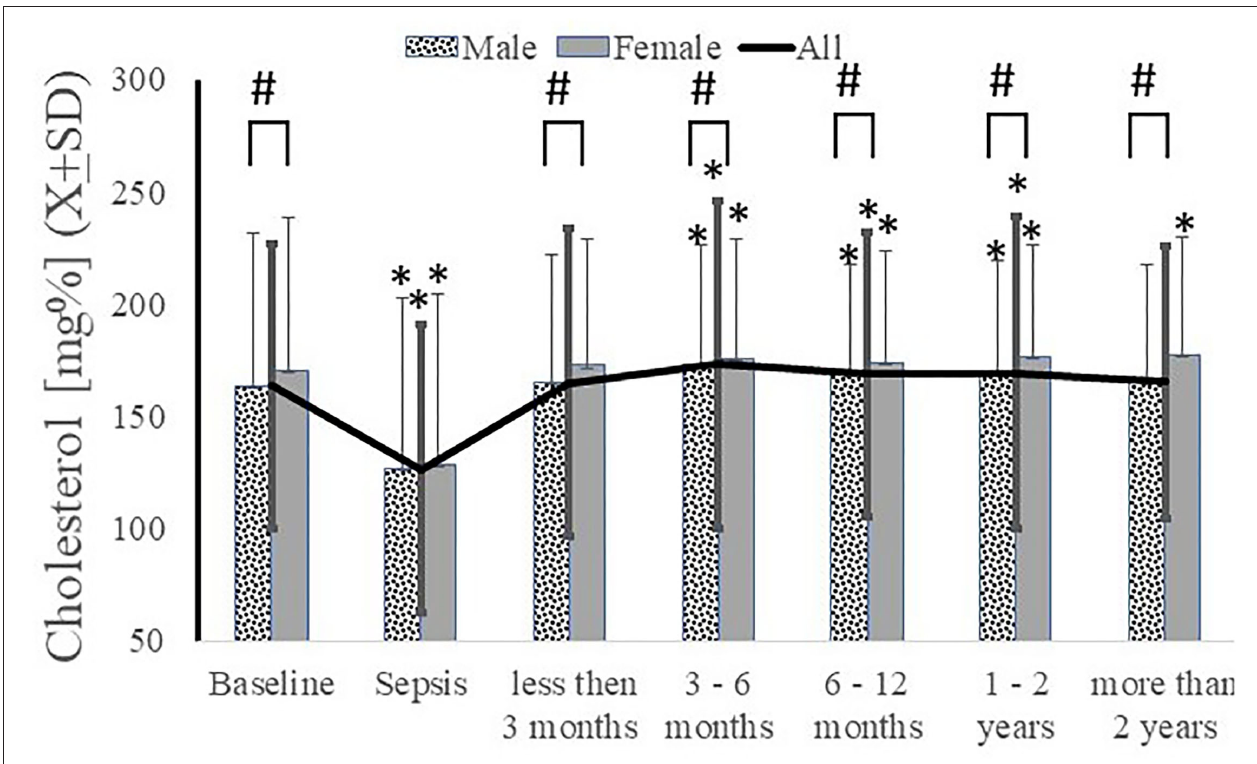
FIGURE 4 | Serum cholesterol decreased acutely during sepsis and never recovered to pre-sepsis level with significantly less recovery in male subjects. * p < 0.05 as compared to baseline, # as compared between genders.